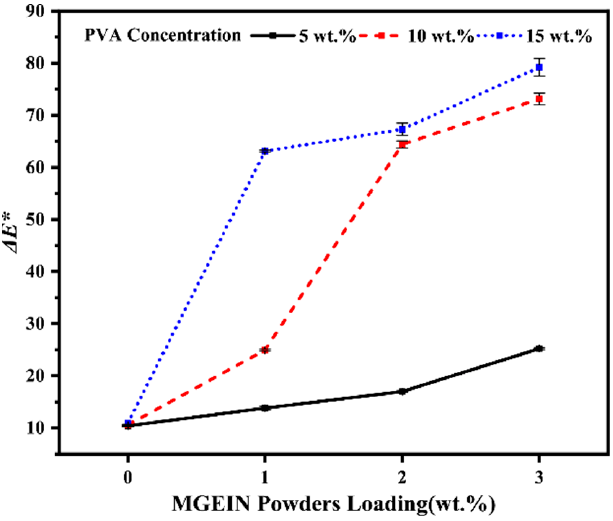
Figure 6. Weight percent gain of Gr/PVA impregnated modified veneers . Figure 6. Chromatic aberration of Gr/PVA impregnated modified